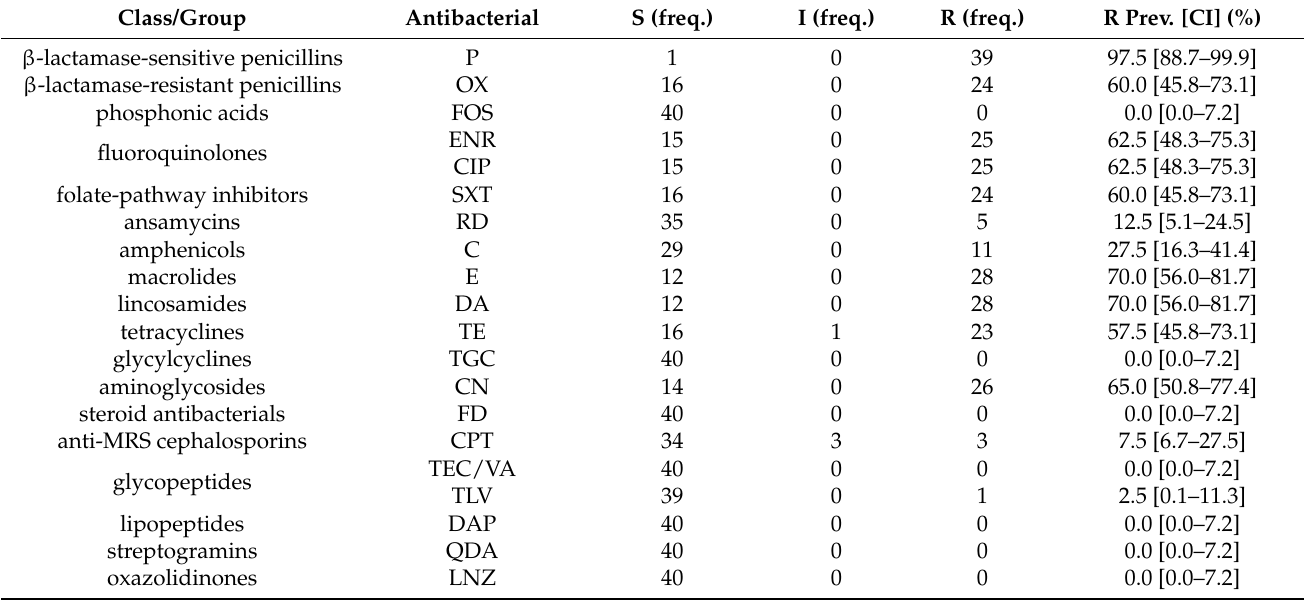
Table 1. Results of antimicrobial susceptibility testing. Absolute frequency of sensitive (S), sensitive to increased dosage (I) and resistant (R) strains are reported along with the prevalence of R strains and 90% confidence intervals (CI) for each antibacterial